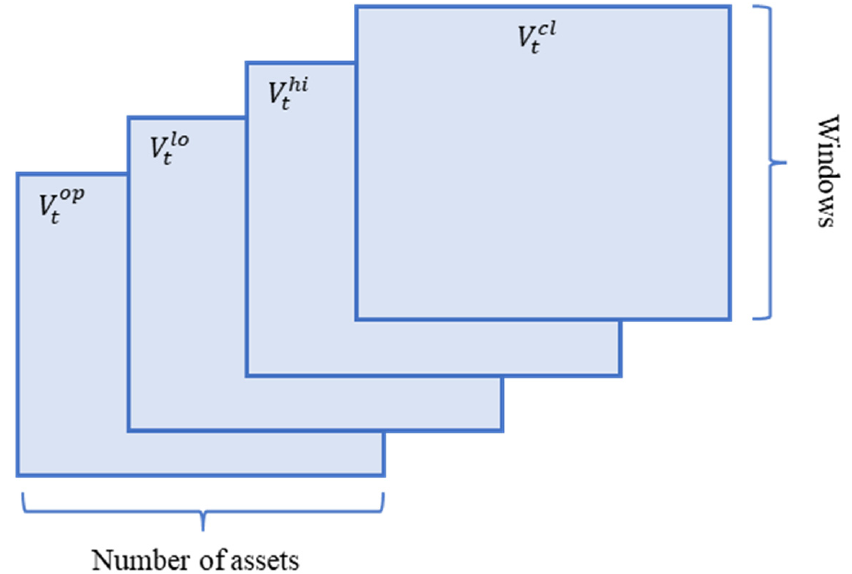
Figure 1. The data structure of the price tensor.